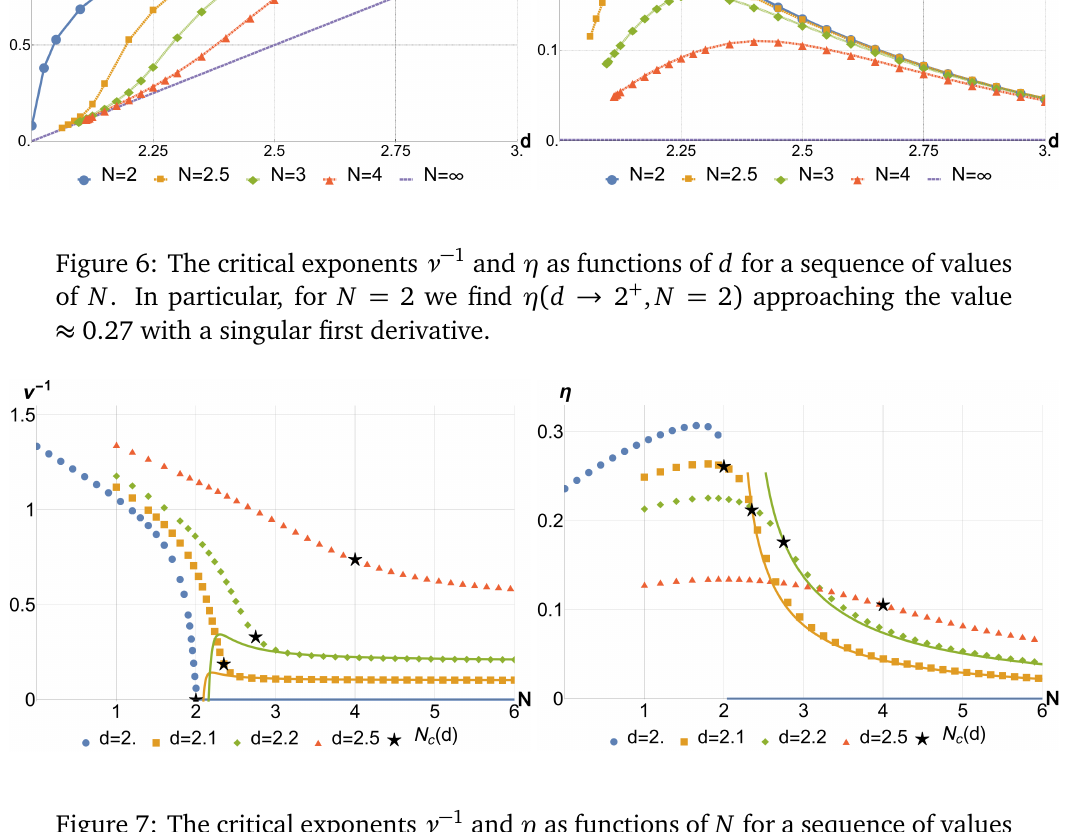
Figure 7: The critical exponents ν − 1 and η as functions of N for a sequence of values of d . Continuous lines denote the ε -expansion predictions; the lines corresponding to d = 2.5 were removed to avoid obscuring the illustration. The stars indicate our ( d ) (see the main estimate of N c